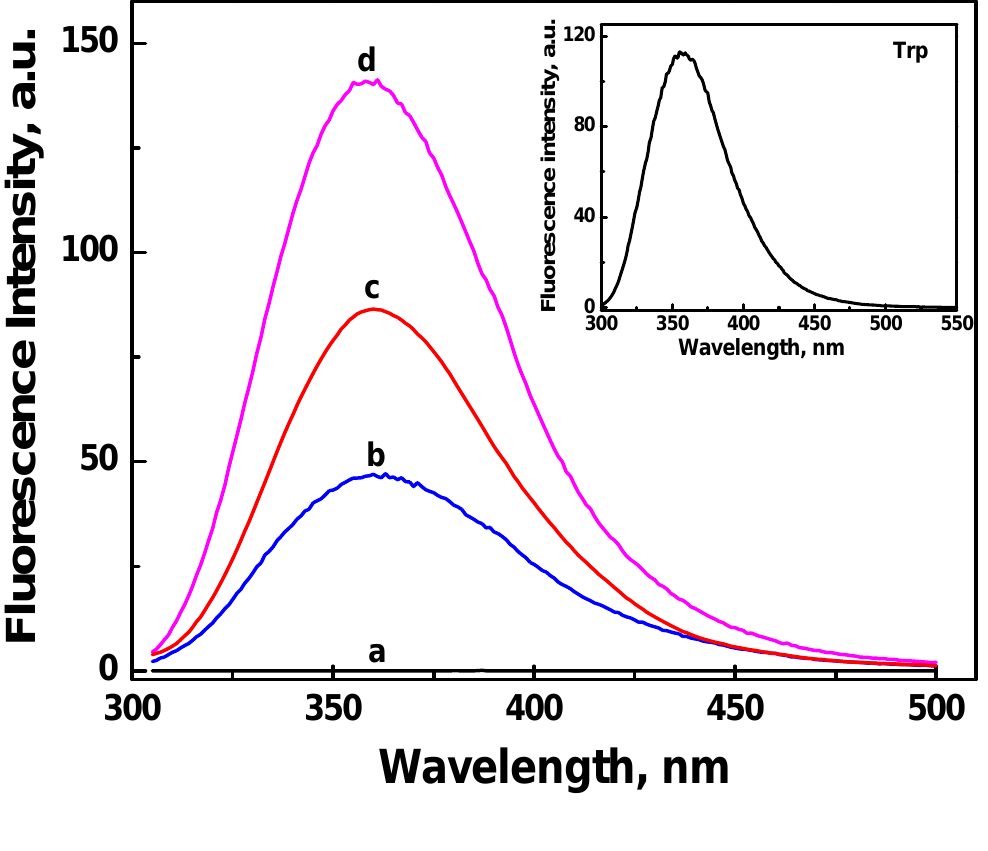
Figure 3. Fluorescence emission spectra of aqueous suspension of ONC: ( a ) alone, and coupled with: ( b ) Trp-EMP, ( c ) Trp and ( d ) Trp-WRF. The insert shows the emission spectrum of an aqueous solution of Trp. The excitation wavelength was 295